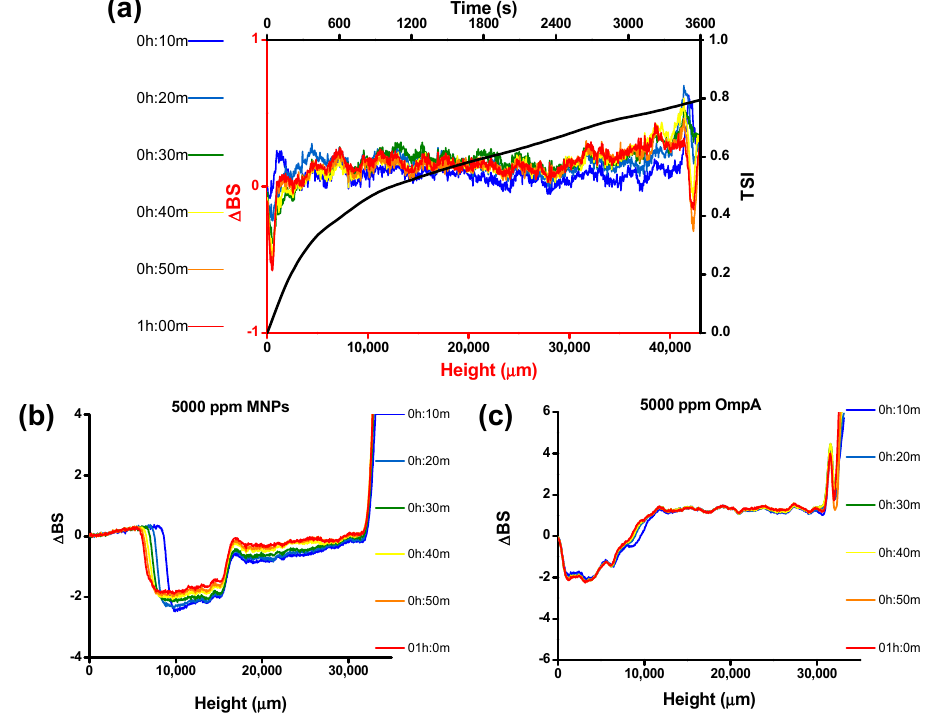
Figure 4. O/W emulsion characterization. ( a ) Δ Backscattering ( Δ BS) for a representative O/W stabilized emulsion (red layer) and time evolution of the Turbiscan Stability Index (TSI) (black layer). Time evolution of Δ Backscattering ( Δ BS) for O/W emulsion prepared with 5000 ppm of ( b ) bare MNP and ( c ) free OmpA. The Δ BS was monitored for 1 h at room temperature.